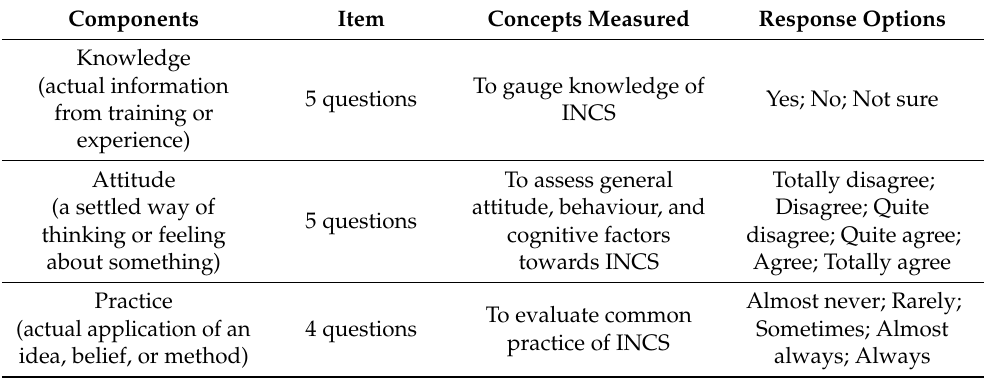
Table 1. The generation of question components for the construct of knowledge, attitude, and practice